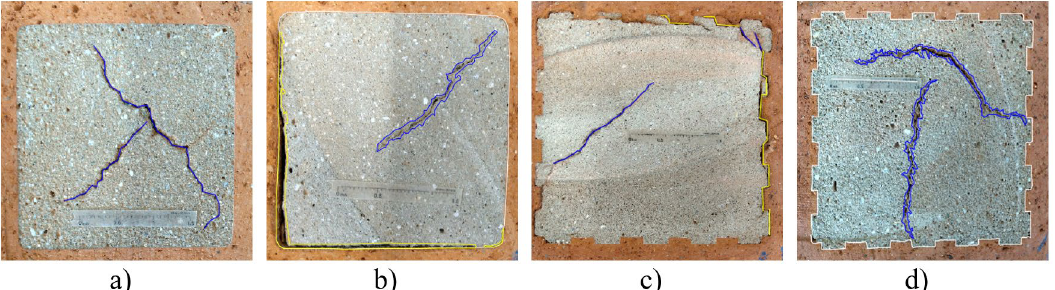
Figure 7. Estimating the effects of shrinkage inside the